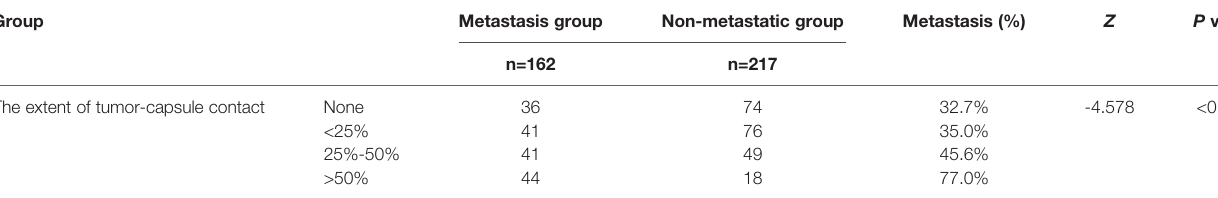
TABLE 2 | Comparison of the extent of tumor-capsule contact between the metastasis group and non-metastatic group. Group